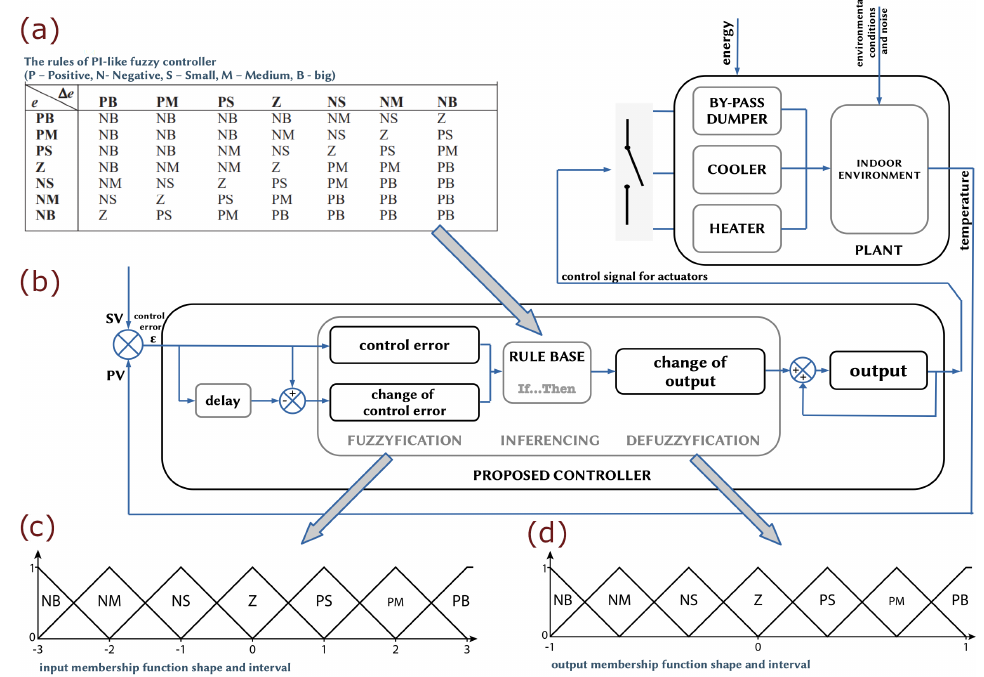
Figure 6. The block diagram of the proposed FLC. ( a ) rule base, example rule read linguistically: IF error IS PositiveBig AND ∆ error IS PositiveBig THEN Output IS NegativeBig ; ( b ) internal structure; ( c ) membership function shapes for input signals ε and ∆ε , default width of each interval is 2 ◦ C and 2 ◦ C /min; ( d ) membership function shapes for output signal, values mapped to desired actuator output, for instance 0. . .255, 0. . .10